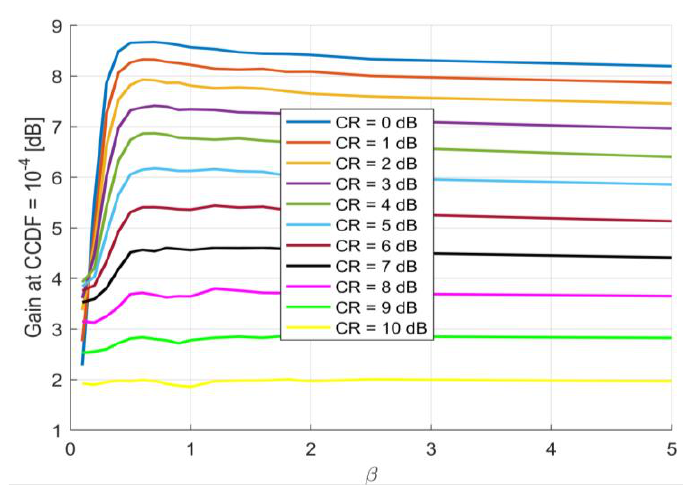
Figure 10. PC-OFDM 16-QAM with variable CRs and smoothness. Information 2020 , 11 , x FOR PEER REVIEW